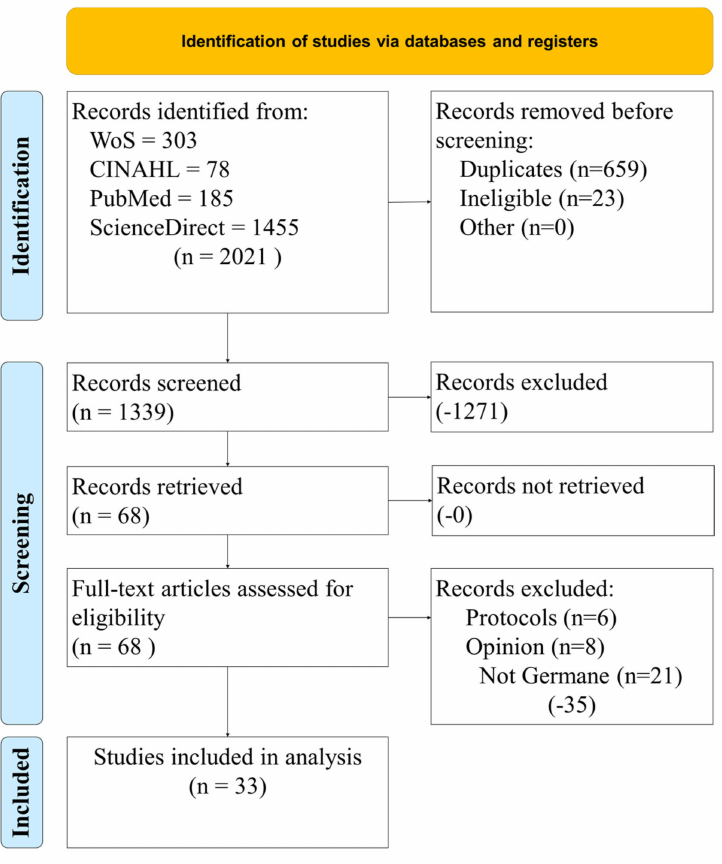
Figure 1. Study selection